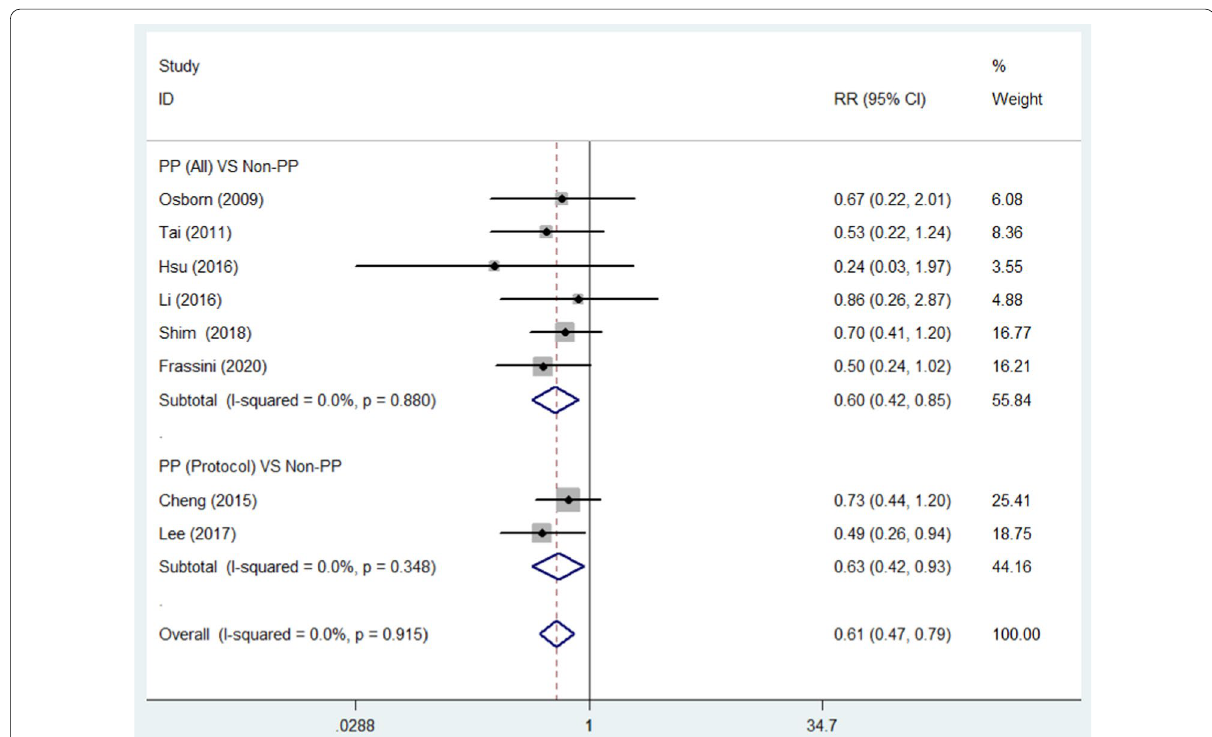
Fig. 2 Forest plot involving a comparison of overall mortality. RR relative risk, CI confidence interval